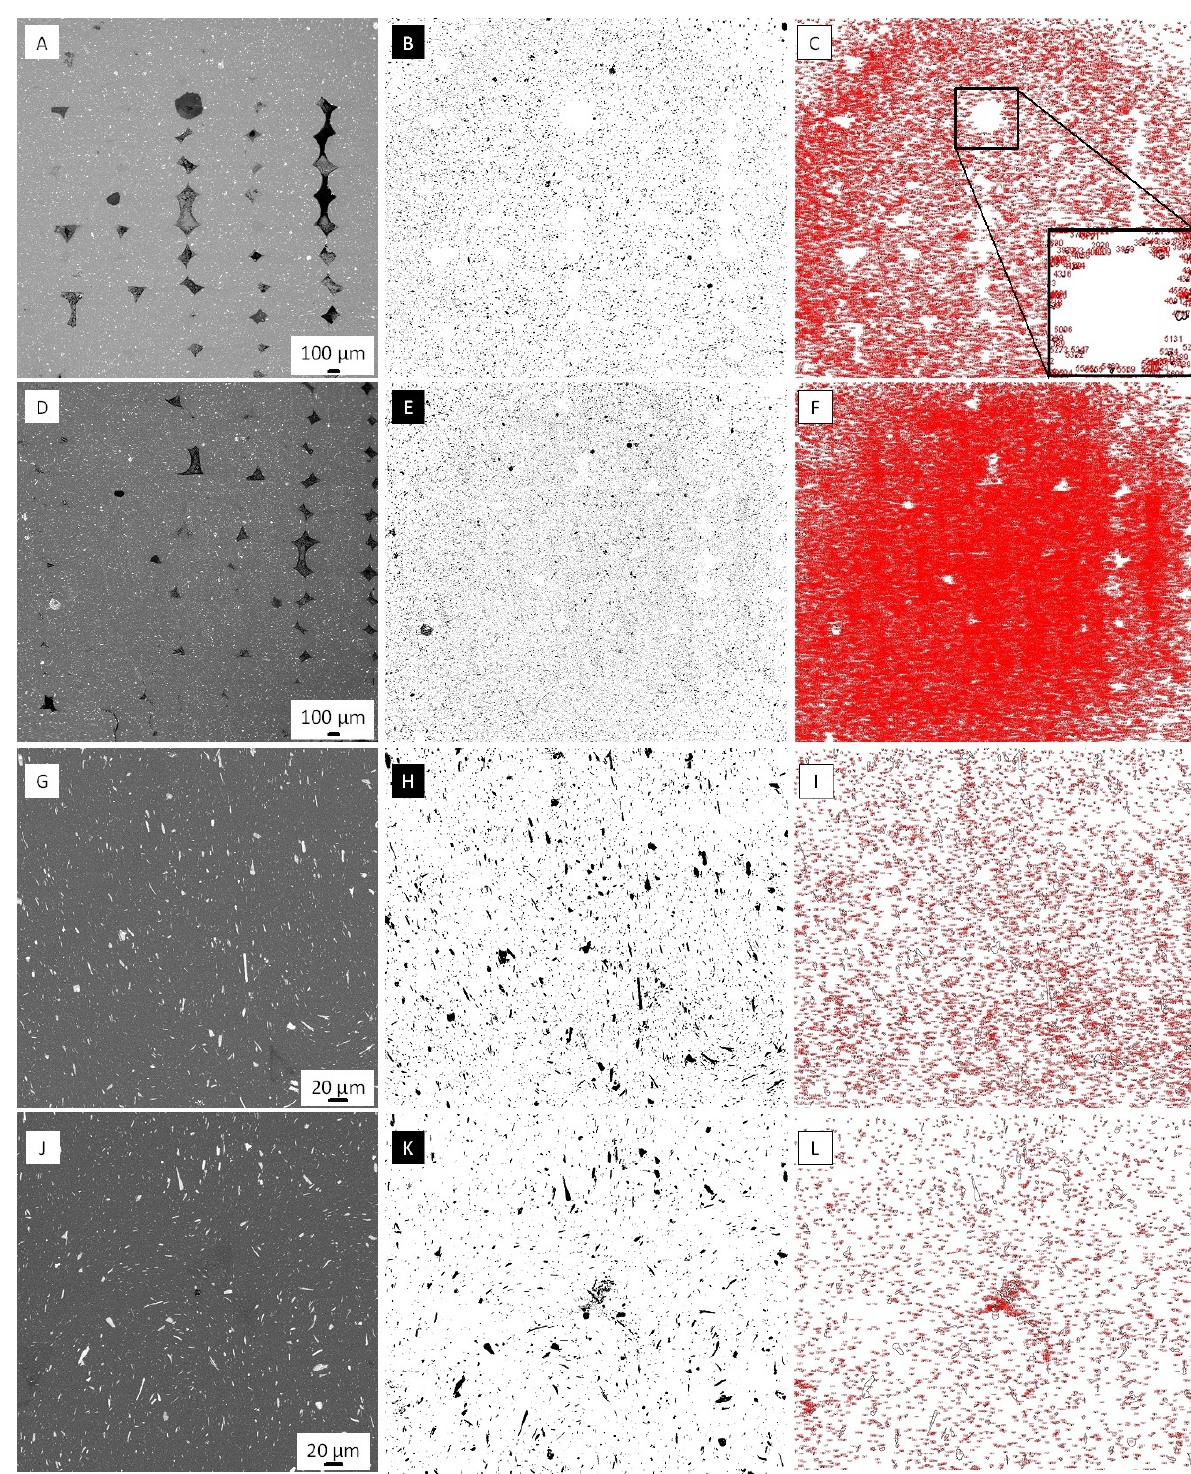
Figure 3. SEM images ( left column ), inverted images ( middle column ), and numbered ceramic fillers of 3D-printed 60Al 2 O 3 /40PLA samples numbered 1 ( A – F ) and 2 ( G – L ). The square area denotes where the representative close-up ( bottom right corner ) of numbered ceramic fillers was taken ( C ).